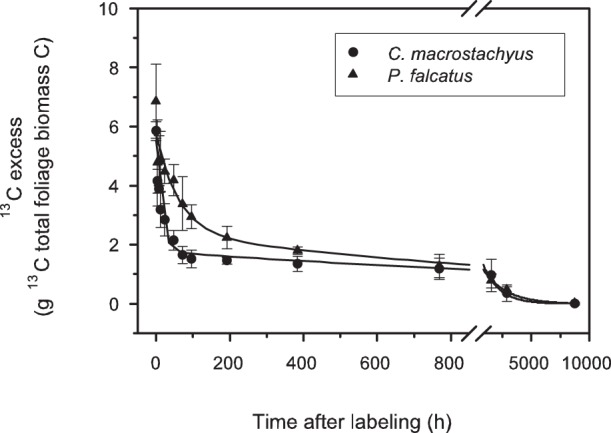
Time course of excess of 13C in total foliage biomass of Croton macrostachyus and Podocarpus falcatus during the one year chasing period.Data are means ± standard deviation (n = 5). Parameters are shown in Table 2.